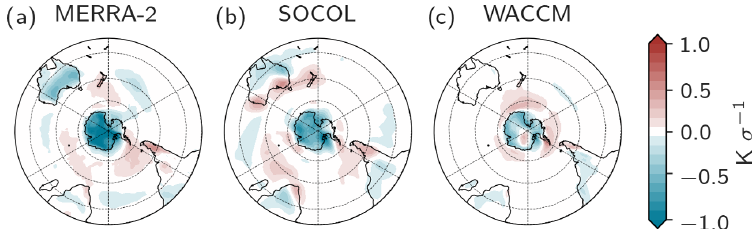
Figure A5. Regression of daily 2m temperature anomalies on the daily 1000hPa SAM index for the October to January time period for the reanalysis data MERRA-2 (a) for the time period 1980–2020 and the CCMs SOCOL (b) and WACCM (c) for 200 model years each.